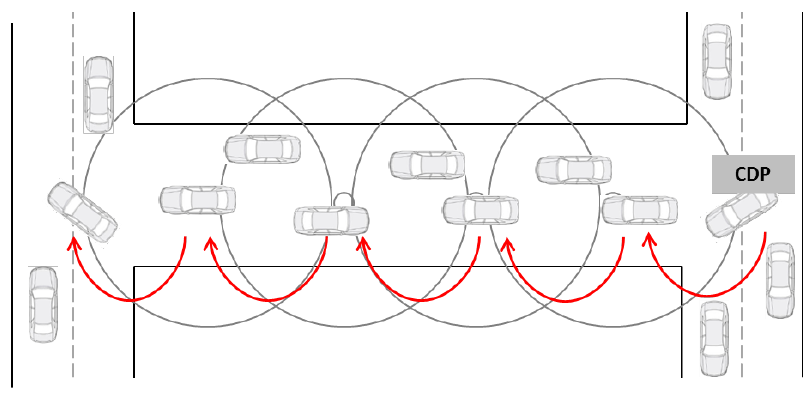
Figure 2. Infrastructure-Free Traffic Information System (IFTIS) in GyTAR.